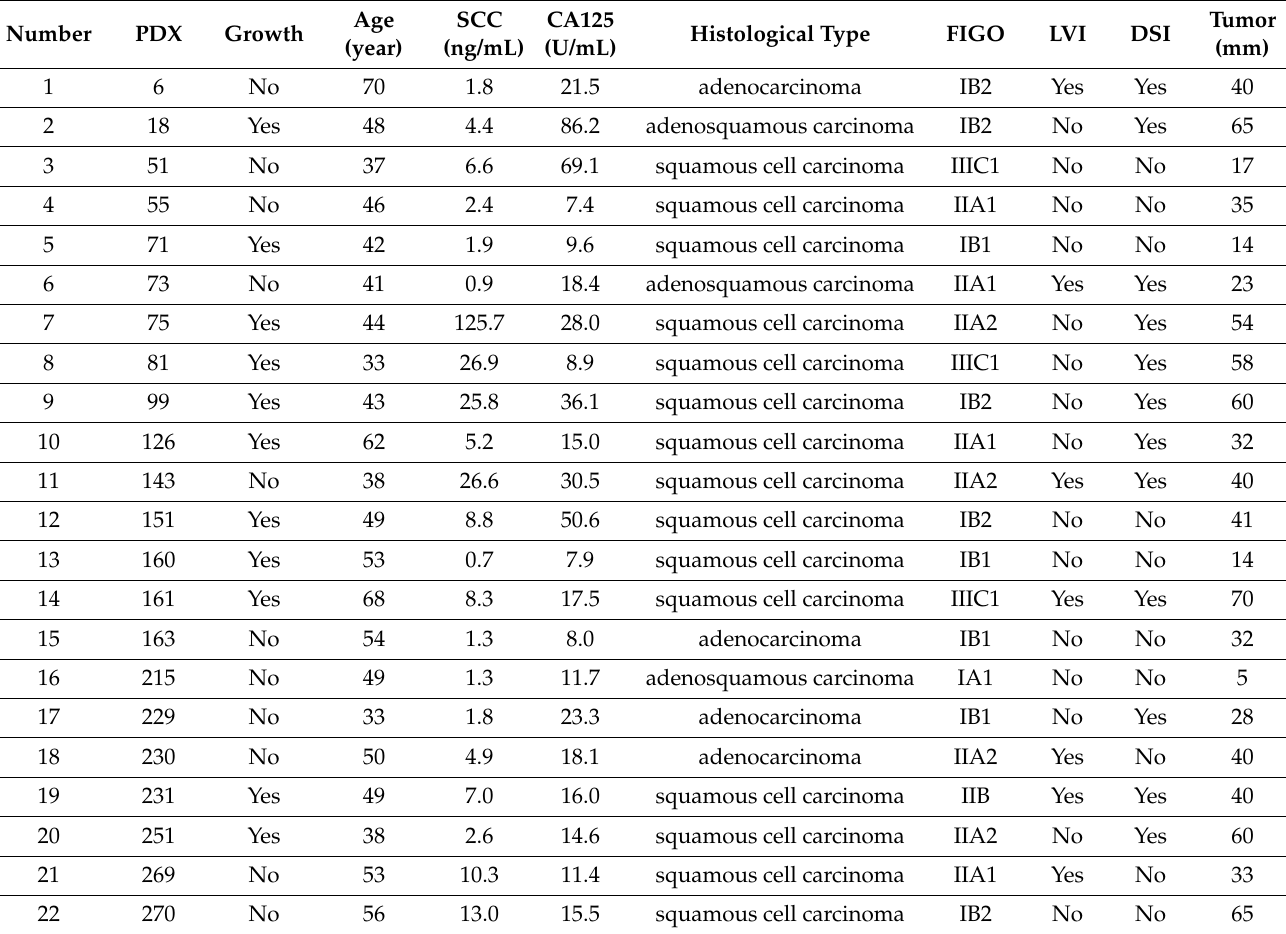
Table 1. Patient Characteristics of Tumorigenicity of Engrafted Tumors in Xenograft